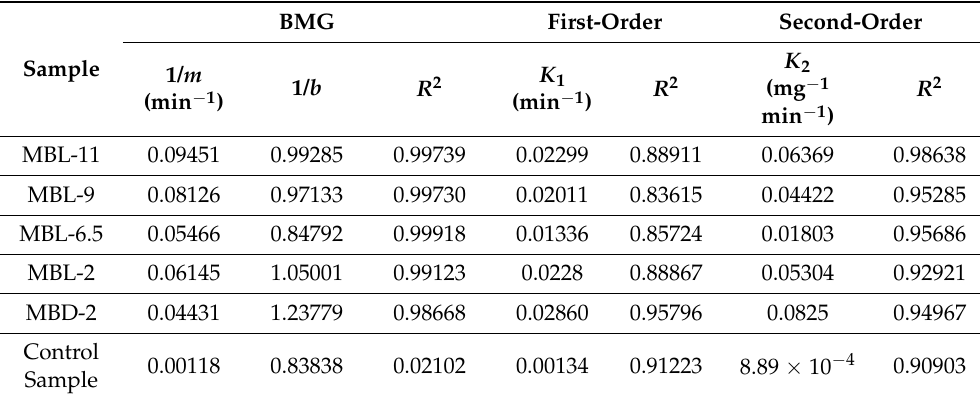
Table 1. Linear regression parameters for the photodegradation of MB extracted based on first-order, second-order and BMG model reaction kinetics were conducted and extracted.